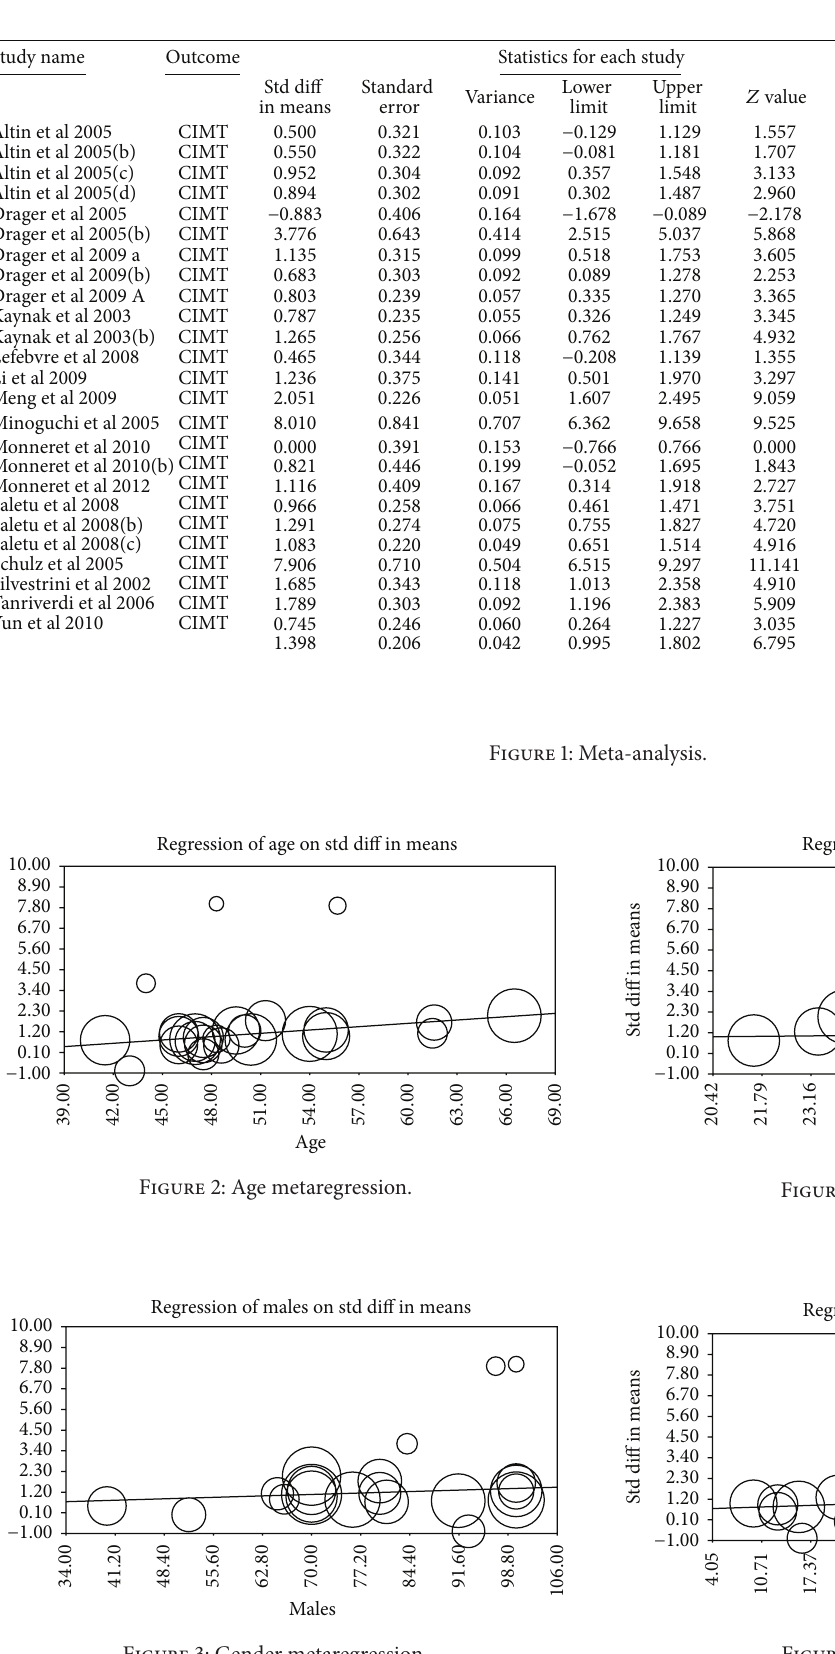
Figure 3: Gender metaregression.